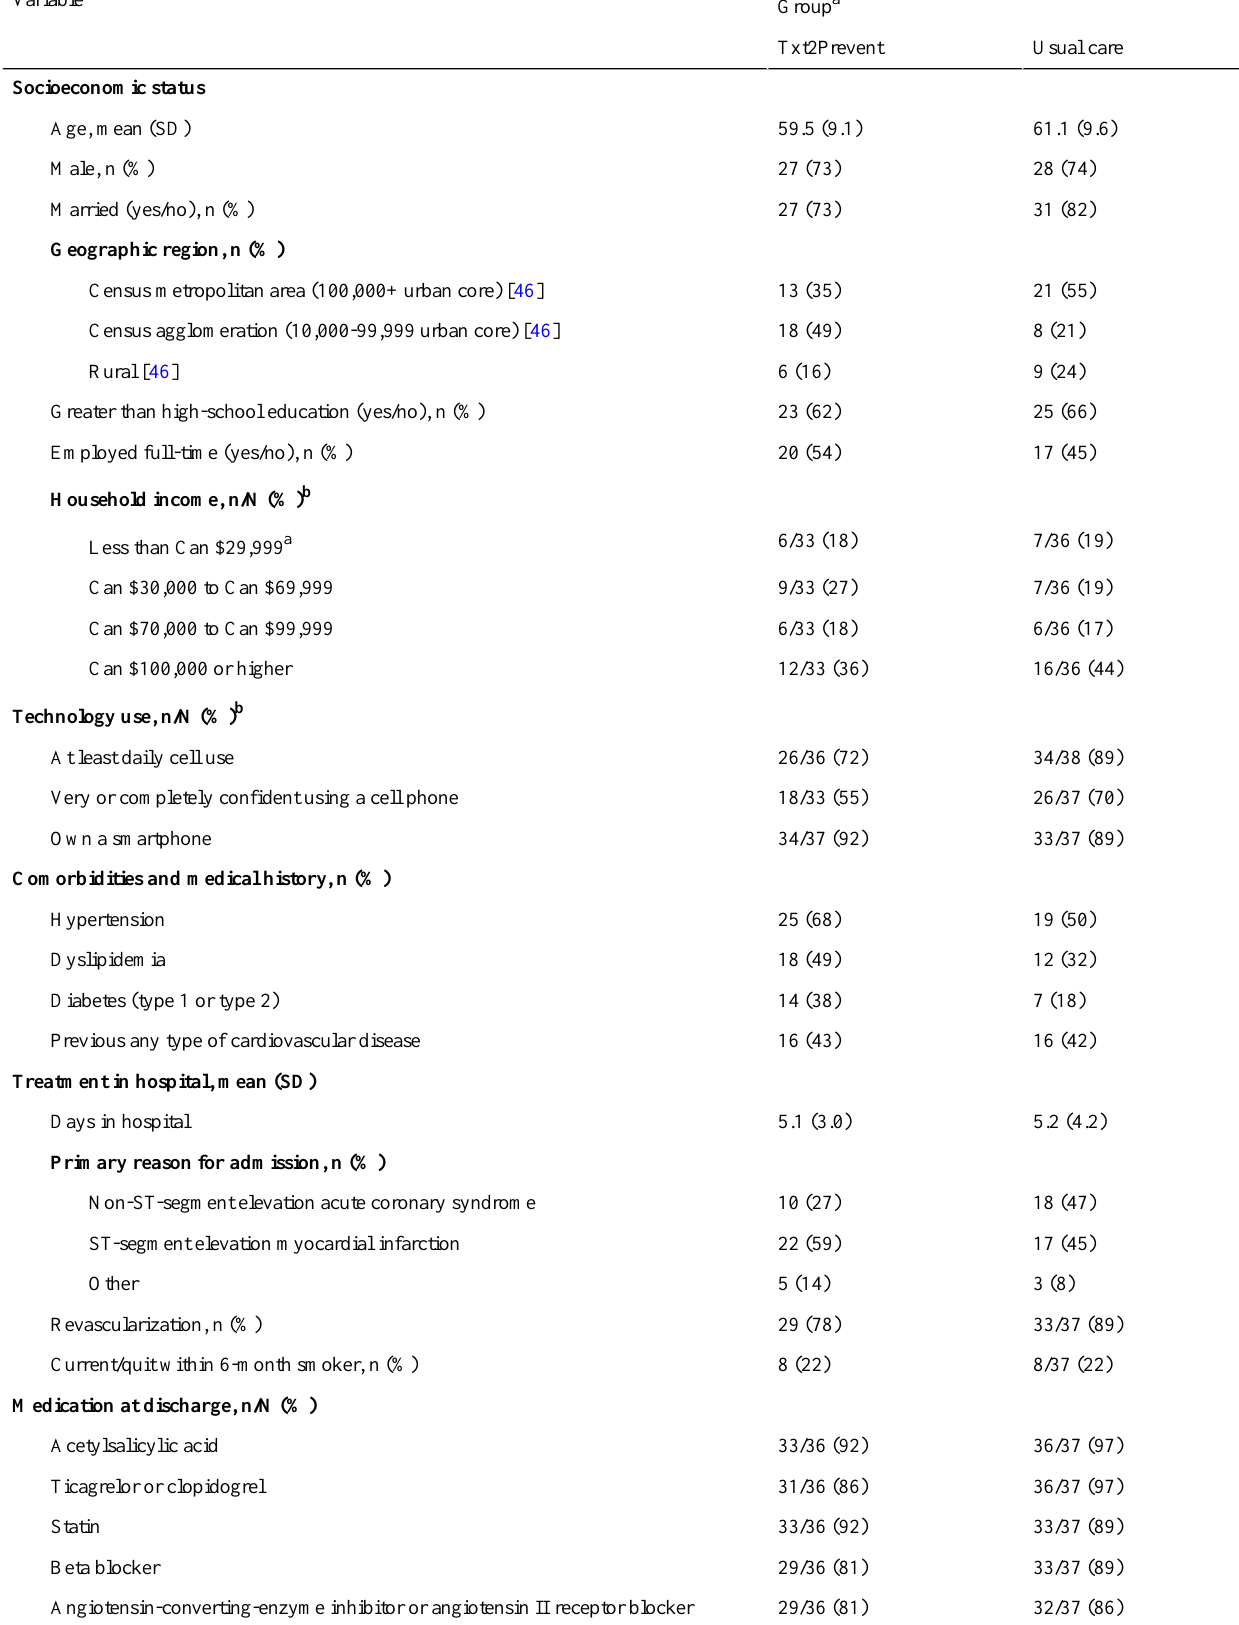
Table 2. Baseline demographics, by